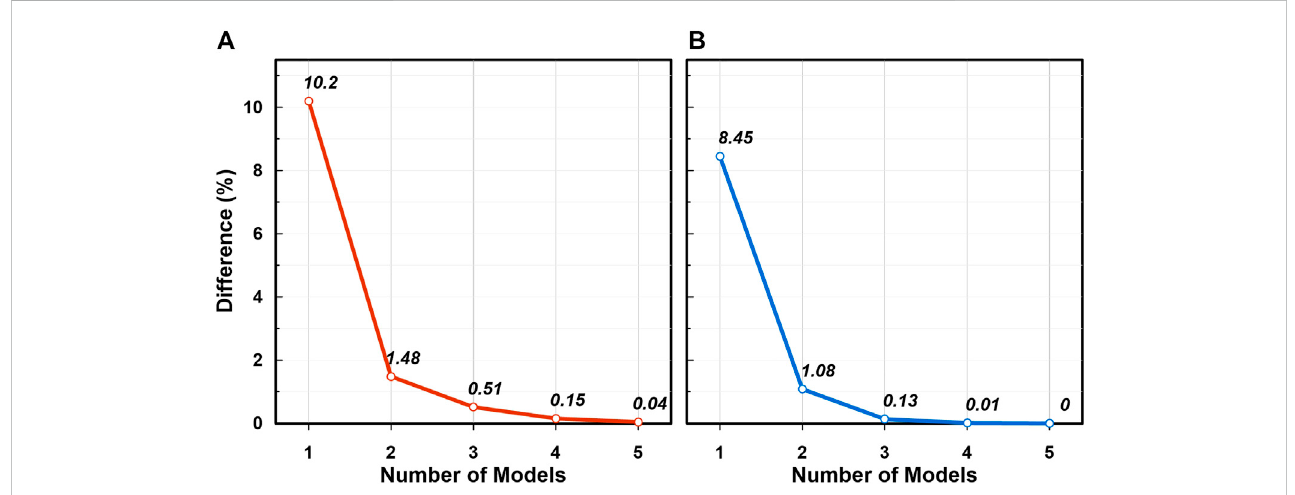
FIGURE 6 PercentagedifferenceofstandarddeviationbetweenonefromthecombinationofnineGMMsandtheotherfromacombinationofdifferentnumbersof GMMs. (A) σ tt and (B) σ b .